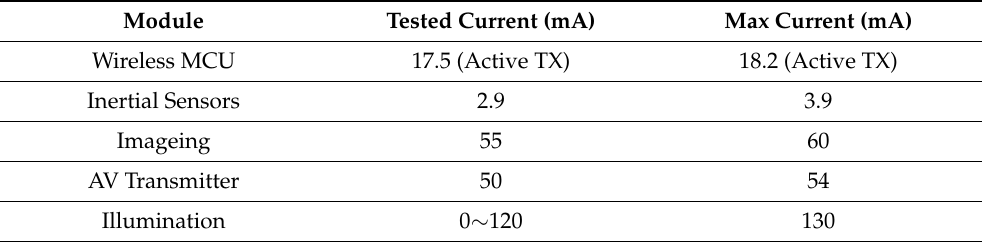
Table 4. Power consumption ratings.